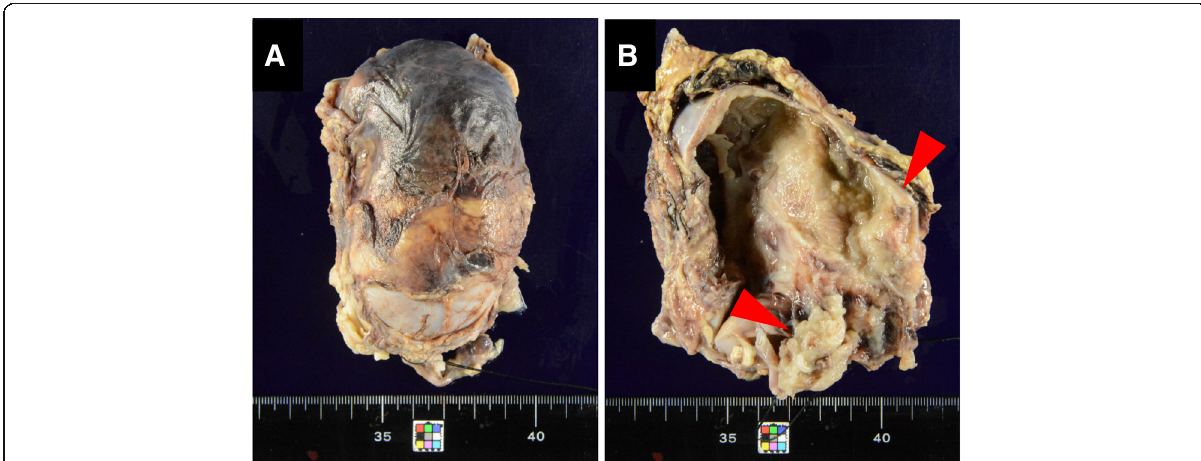
Fig. 3 Gross findings of the resected right kidney. a The tumor was localized from the upper pole to the middle portion. b The cystic septum within the tumor had disappeared. Some solid areas were seen (arrow